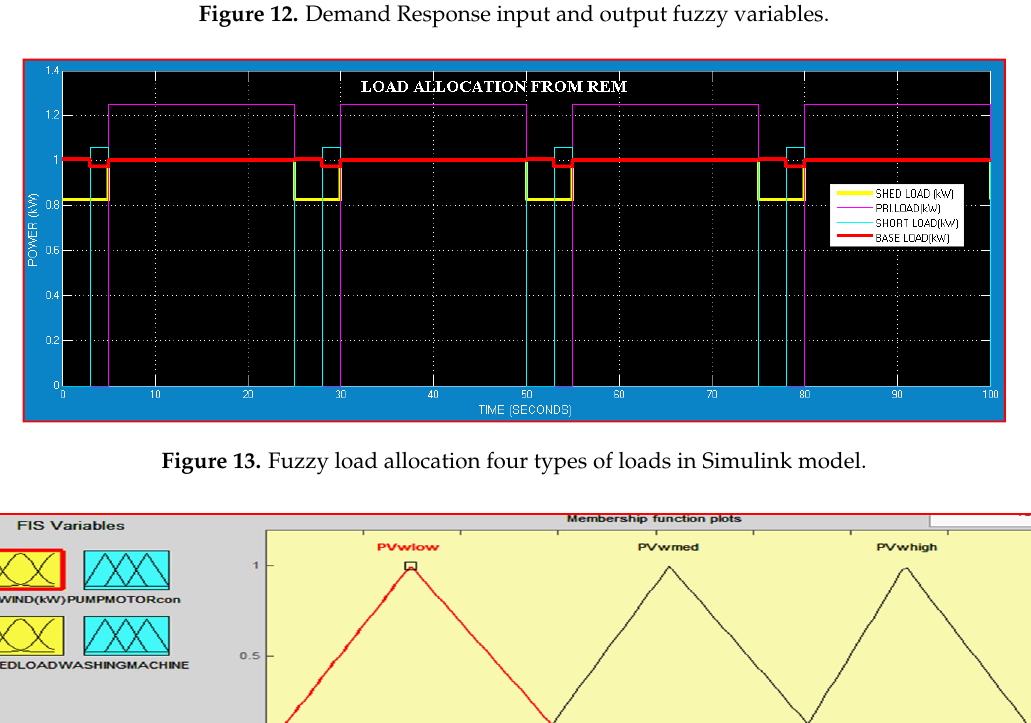
Figure 12. Demand Response input and output fuzzy variables.